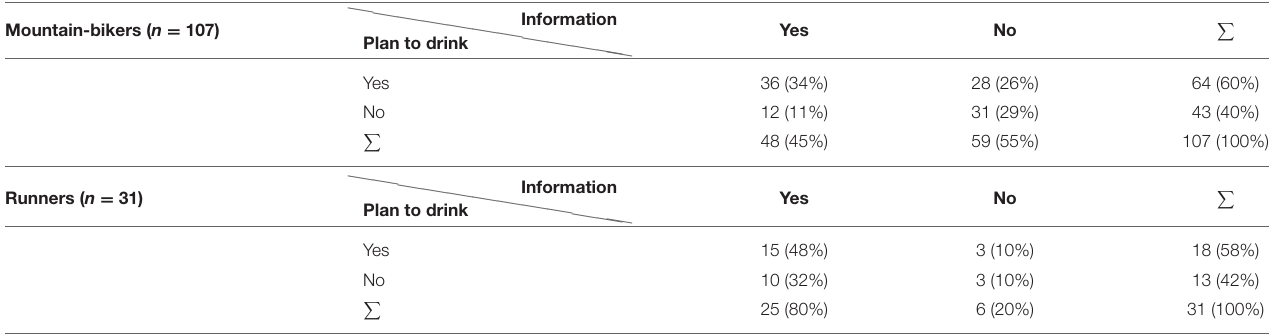
TABLE 4 | Distribution of the answers of mountain-bikers and runners to questionnaire questions: “Have you ever heard how much you should drink prior to, during and after the race?” and “Do you have any plan for your fluid intake during the race?” Mountain-bikers ( n = 107)